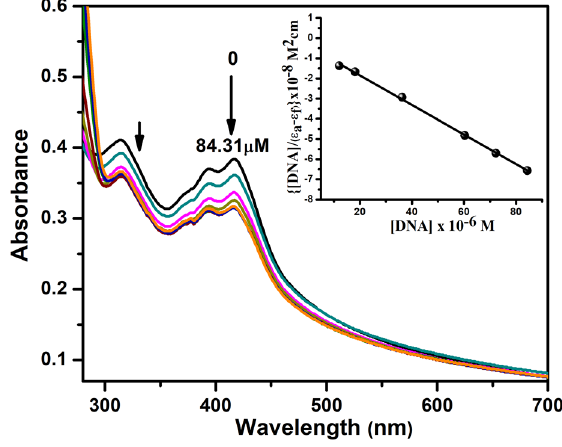
Figure 3. Absorption pattern of complex 1 (60 μ M) upon the addition of ctDNA (0–84.31 × 10 –6 M); Inset: Plots of [DNA]/( ε a – ε f ) vs. [DNA] for the titration of ctDNA with complex.